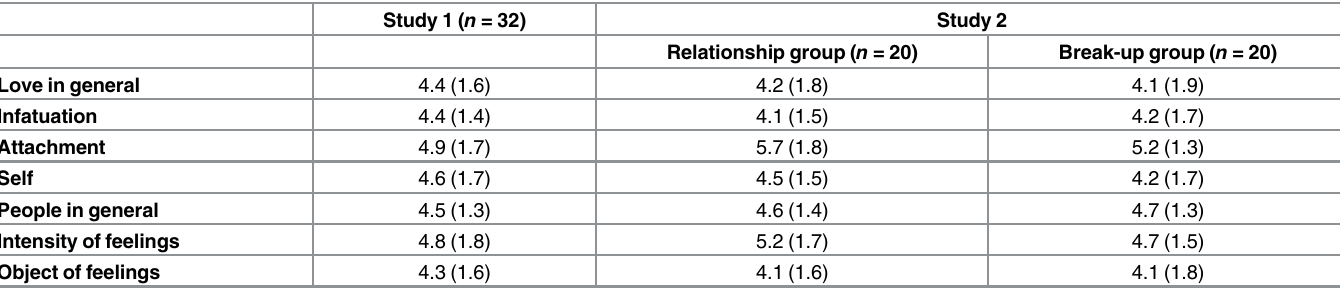
Table 4. Mean (SD) perceived control over seven aspects of